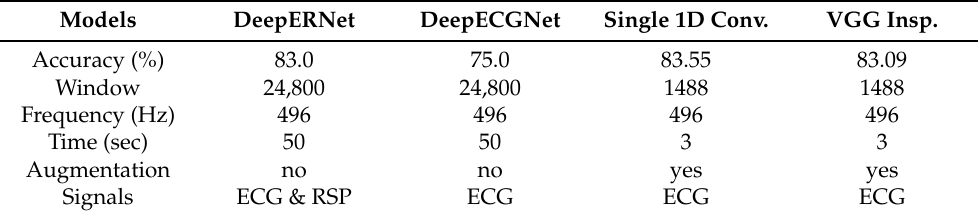
Table 7. Stress classification task with 3 stress labels (low, moderate, high).